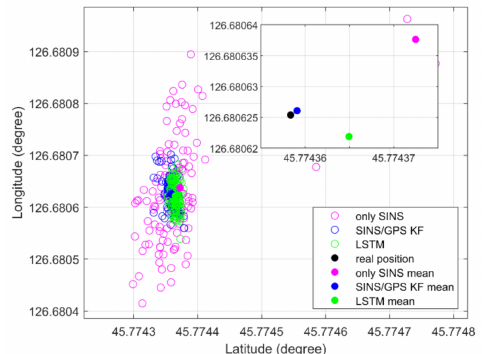
Figure 8. Static position of